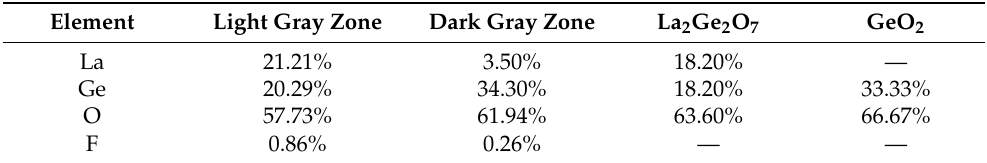
Figure 11. SEM images of Ge-La after thermal treatment at 1500 ◦ C. Table 8. EDX results of the Ge-La after thermal treatment and the theoretical atomic percentages of different elements of the possible products in Ge-La